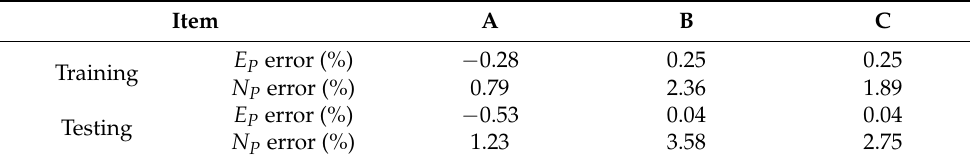
Table 3. Errors as they varied by number of hidden layers.